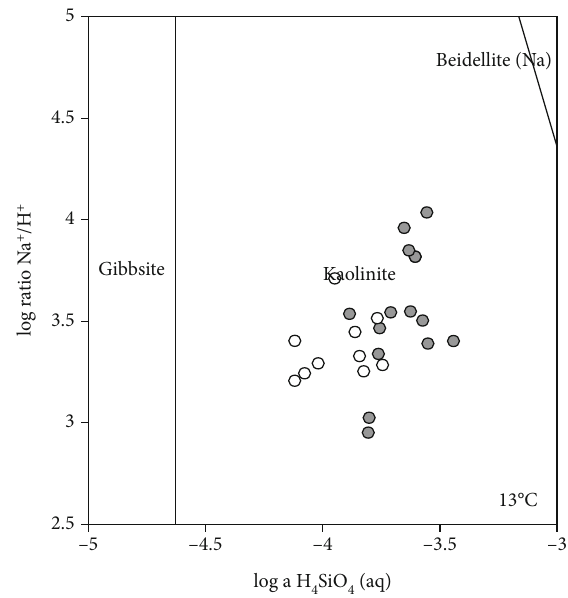
Figure 9: Activity plot of log a (H symbols are as Figure 5.